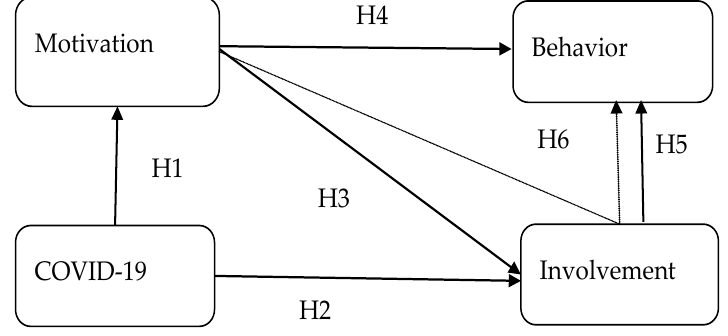
Figure 1. Research framework.